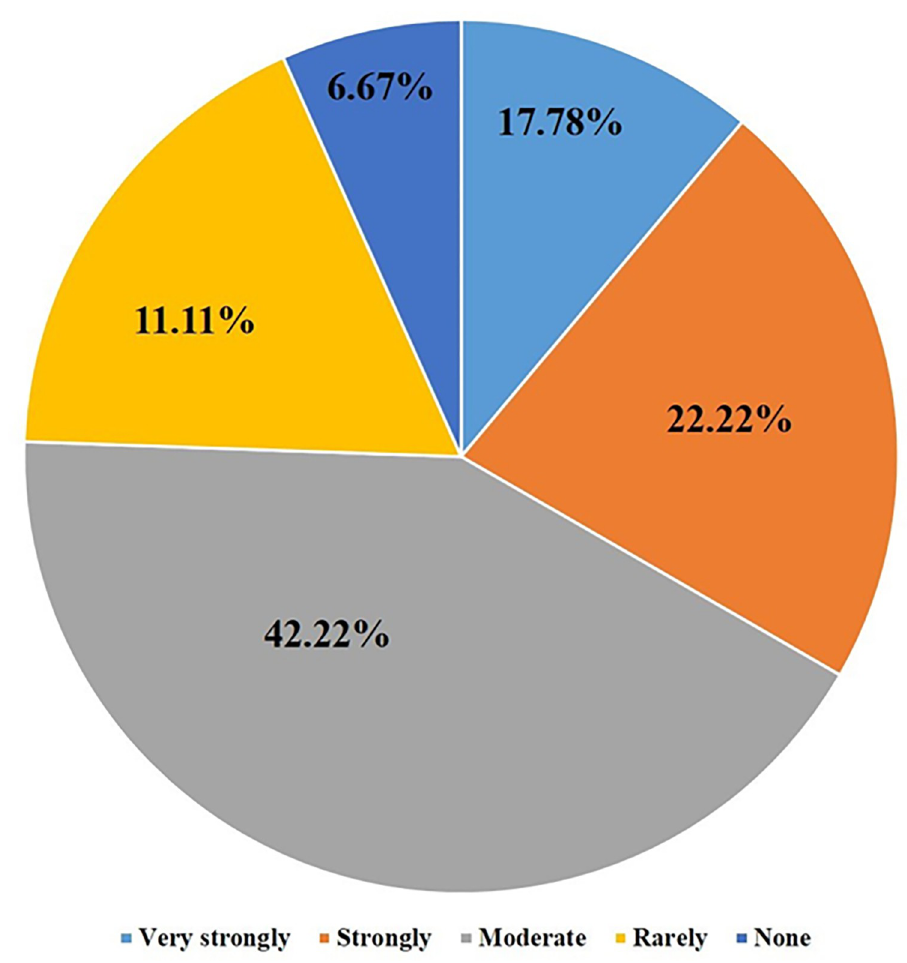
Fig 2. Desire to buy O‘view M (smart phone based self- semen analysis